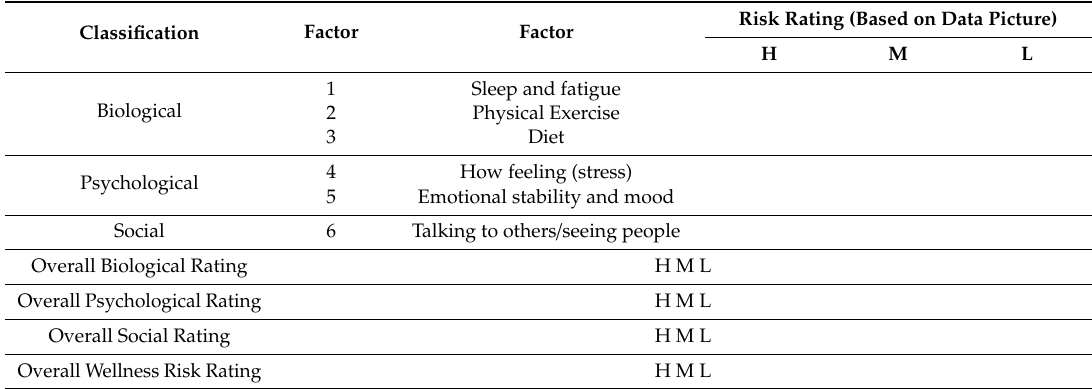
Table A4. Provisional risk assessment algorithm.